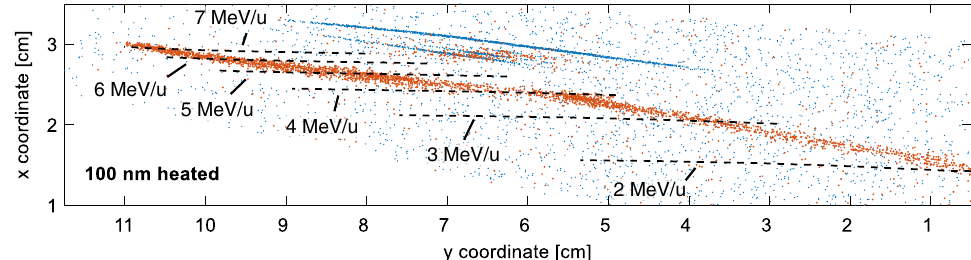
Figure 5. CR-39 raw data after background removal for a laser shot onto a 100 nm thin gold foil that was laser-heated before the shot for surface cleaning. The iso-energy lines starting from 2 MeV/u up to 7 MeV/u are indicated by black dotted